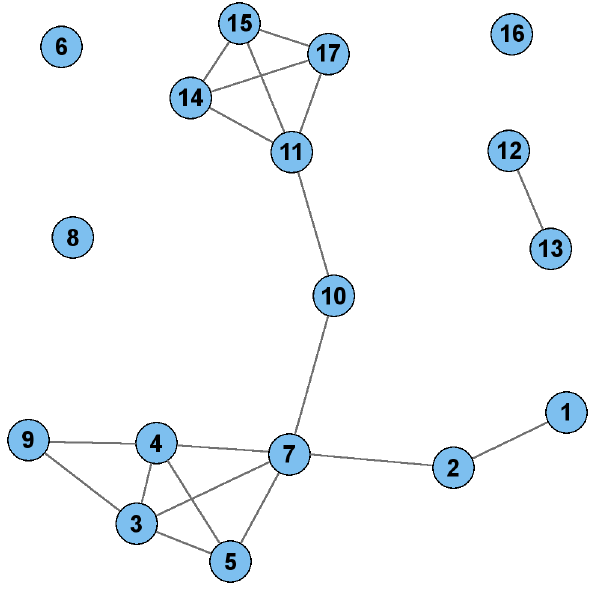
Figure 4. Plot of PCC edges for the 17 SNPs in the ps_1 bloc. BlocBuster connected these 17 nodes into a single connected component, while PCC separated them into disconnected components. Overall, PCC identified 19 pair-wise correlations and CCC identified 39 correlations amongst these SNPs, as represented by edges in this plot and Figure 2.